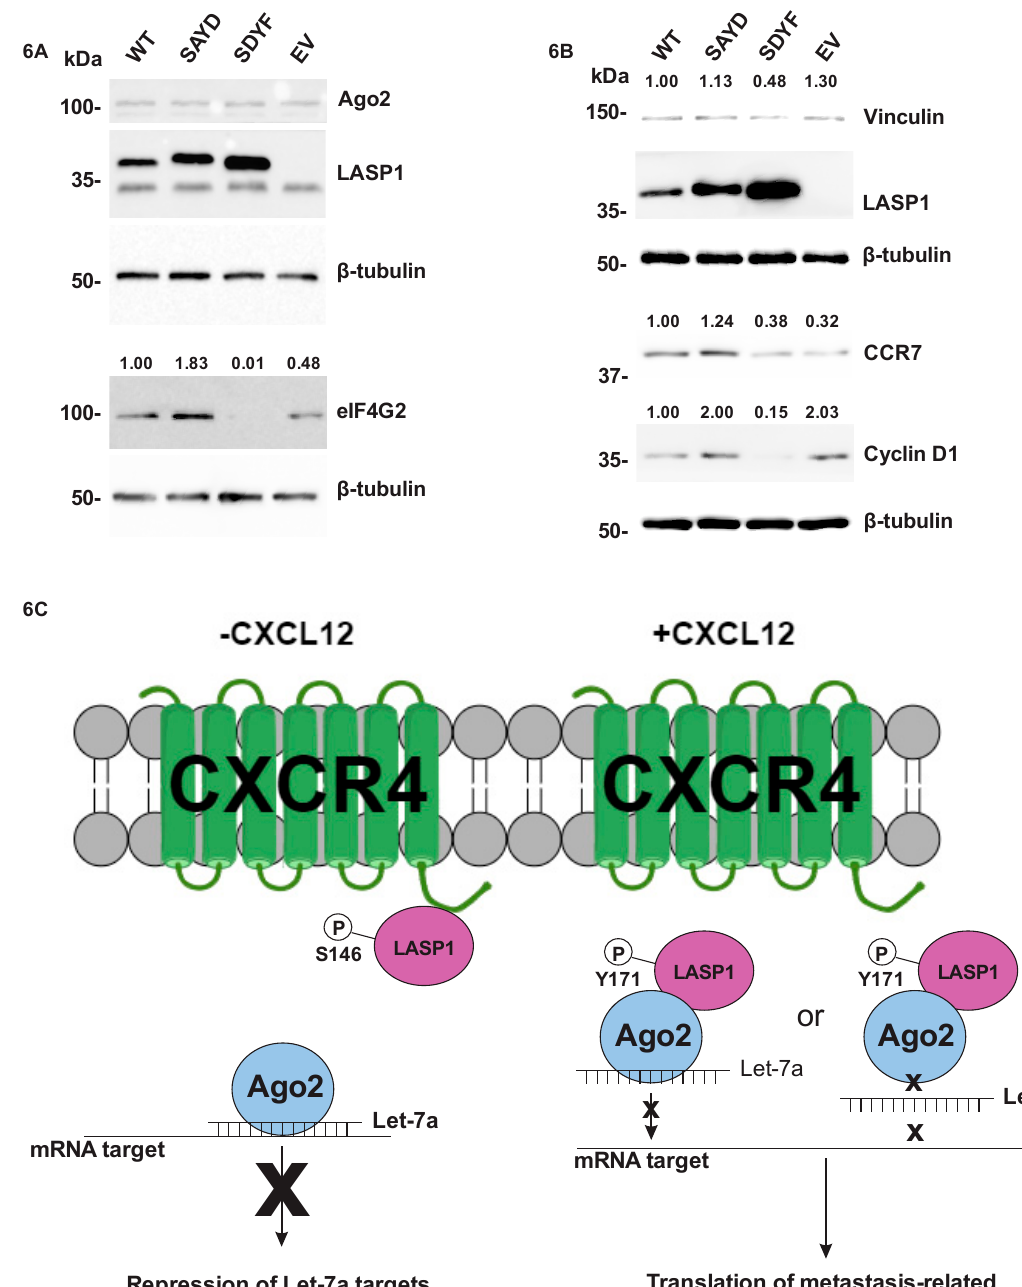
Figure 6. Protein Expression of Let-7a Target Genes are Altered in a LASP1-Ago2 Interaction-Dependent Manner. ( A ) Western blotting of Bone-Un LASP1 KO cell lines with re-introduced LASP1 and its mutants for Ago2 expression and eIF4G2 ( n = 3). ( B ) Western blotting of additional Let-7a targets vinculin ( n = 3), CCR7 ( n = 3), and cyclin D1 ( n = 3). ( C ) Model of the CXCR4-LASP1-Ago2 pathway in the presence or absence of CXCL12. In the absence of CXCL12, LASP1 is phosphorylated on S146 and remains bound to CXCR4, while Ago2 can freely use Let-7a to repress motility-related targets. In the presence of CXCL12, CXCR4 is stimulated which induces dephosphorylation of LASP1 on S146 and phosphorylation on the Y171 site. Once phosphorylated on Y171 LASP1 can bind to Ago2 and alter Let-7a driven RNAi. Two of the multiple possibilities of how LASP1 could prevent Let-7a driven RNAi are illustrated; first, where LASP1 binds to Let-7a-bound Ago2 and interferes with target binding; second, where LASP1 binds to Ago2 and prevents Ago2 binding to Let-7a. Uncropped version of the Western Blots is available in Figure